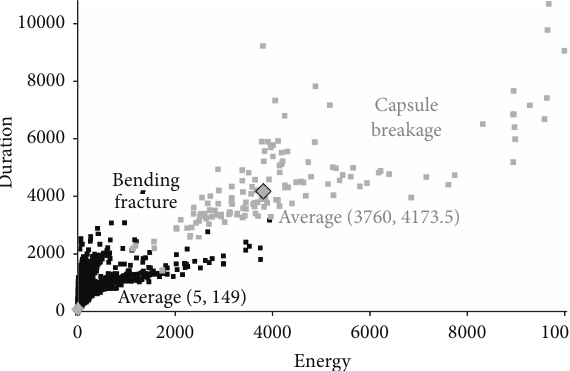
Figure 15: Clustering based on energy and duration features.